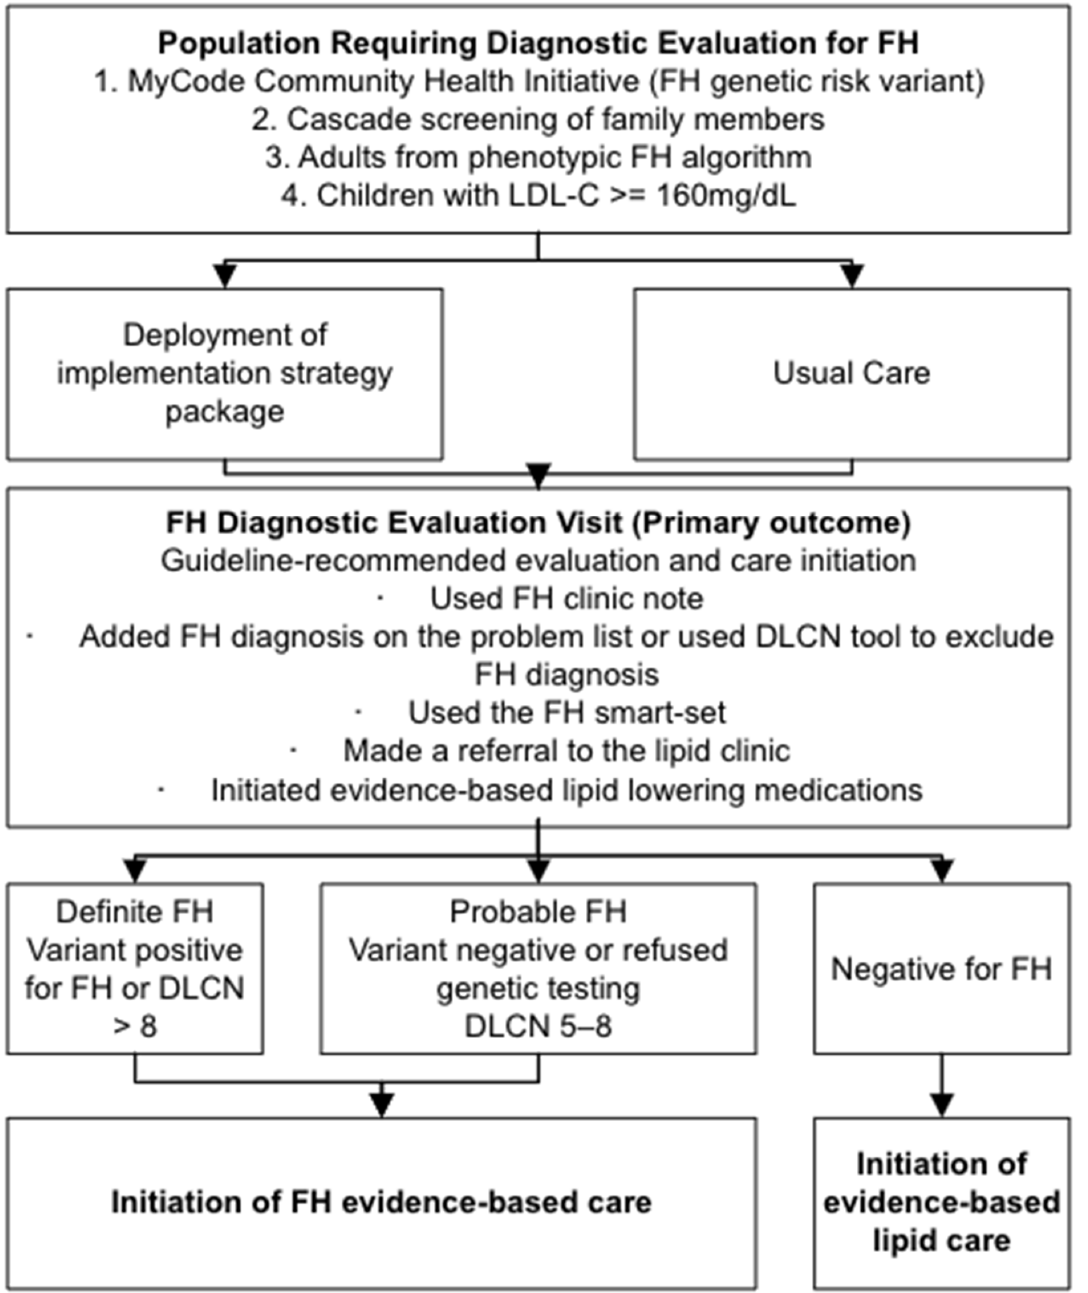
Figure 2. FH Diagnostic Evaluation Program . ASCVD, atherosclerosis cardiovascular disease; DLCN, Dutch Lipid Clinic Network score; FH, Familial hypercholesterolemia; Clinics will move from